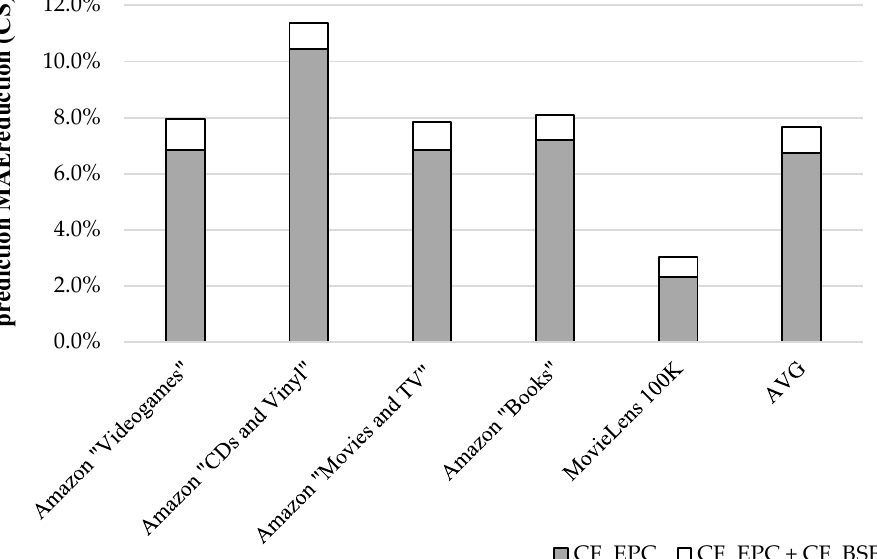
Figure 5. MAE reduction achieved by the inclusion of proposed algorithm to the CF EPC algorithm, when using the CS user similarity metric.